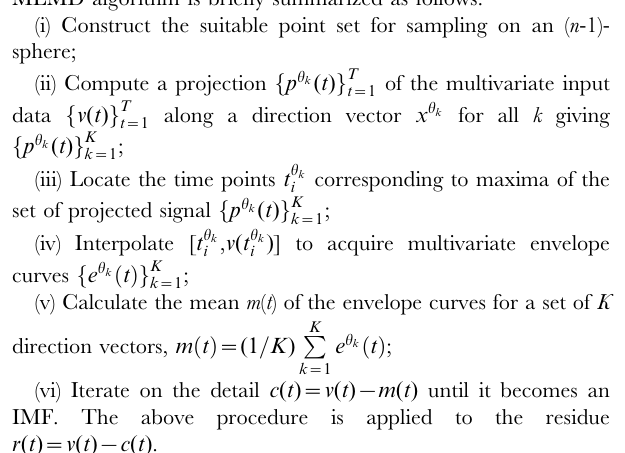
IMF distance between the signal and noise channels distance between noise channels (95% confidence